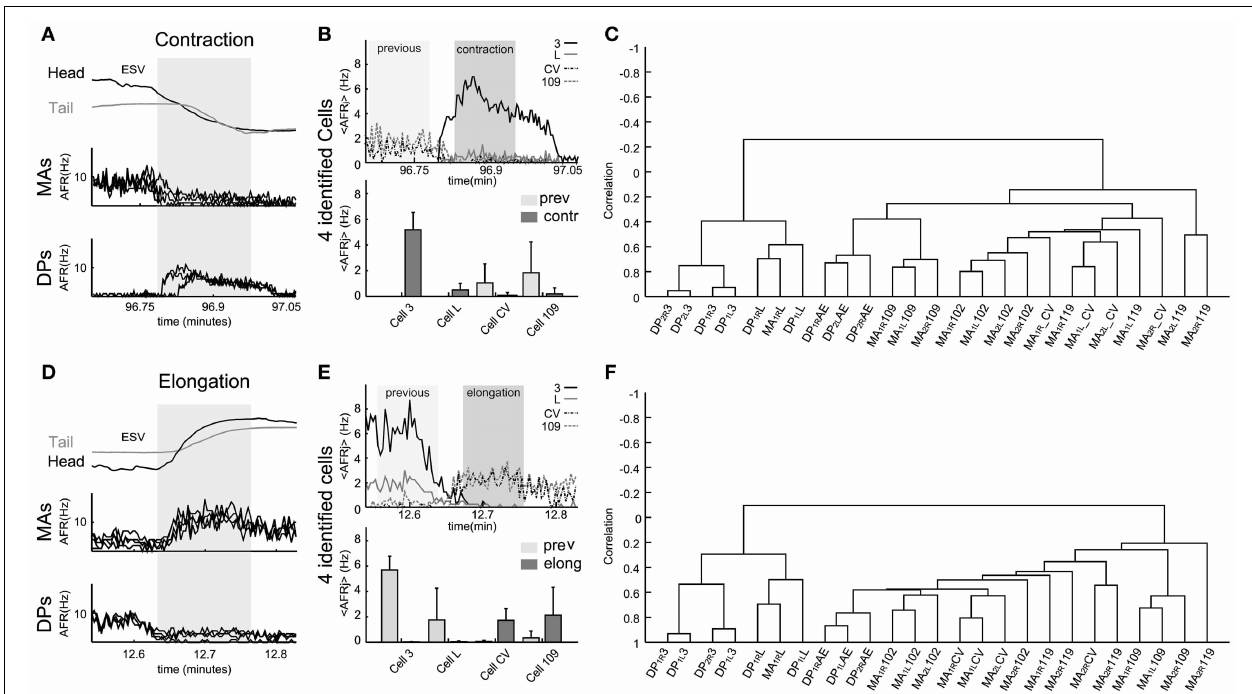
from 0 to 5.72 ± 1.3; cell L, from 0 to 0.71 ± 0.35. Inhibitors exhibited a fall in their activity: cell CV, from 1.02 ± 1.3 to 0.18 ± 0.15; and, cell 109, from 1.88 ± 1.9 to 0.20 ± 0.15. (C) Dendrogram obtained from the hierarchical analysis computed from all the contraction episodes detected during the whole experiment. (D) Similar plot as in (A) for an elongation lasting about 30s (dark zone). (E) As in (B) , top traces show the < AFR j > from the same cells during elongation. Excitors from DP decreased their activity: Cell 3, from 5.89 ± 0.99 to 0; cell L, from 1.61 ± 1.85. Inhibitors exhibited a fall in their activity: cell CV, from 0.01 to 1.56 ± 0.6; and, cell 109, from 0.32 ± 0.2 to 2.12 ± 2.30. (F) Dendrogram obtained from the hierarchical analysis from all elongation episodes detected during the whole experiment. Names of the nerves as in Figure 5